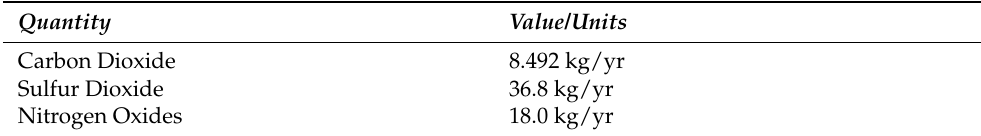
Table 10. Emission profile for system